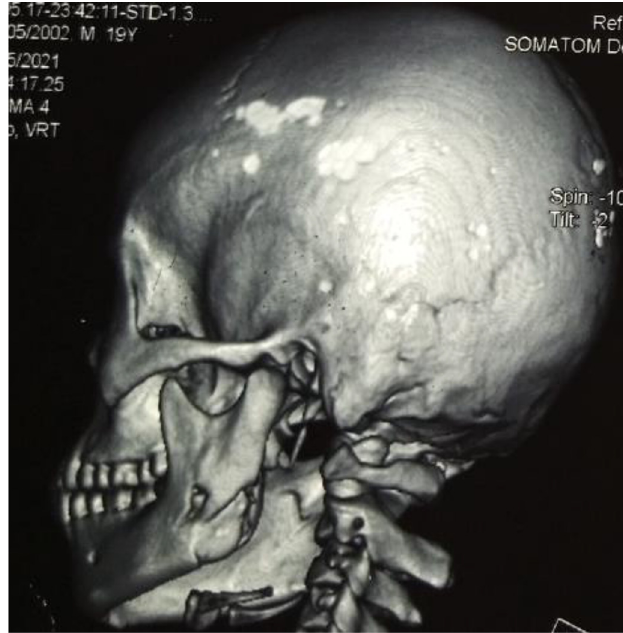
Fig. 5. CT aspect, complex fracture of the angle and the left mandibular